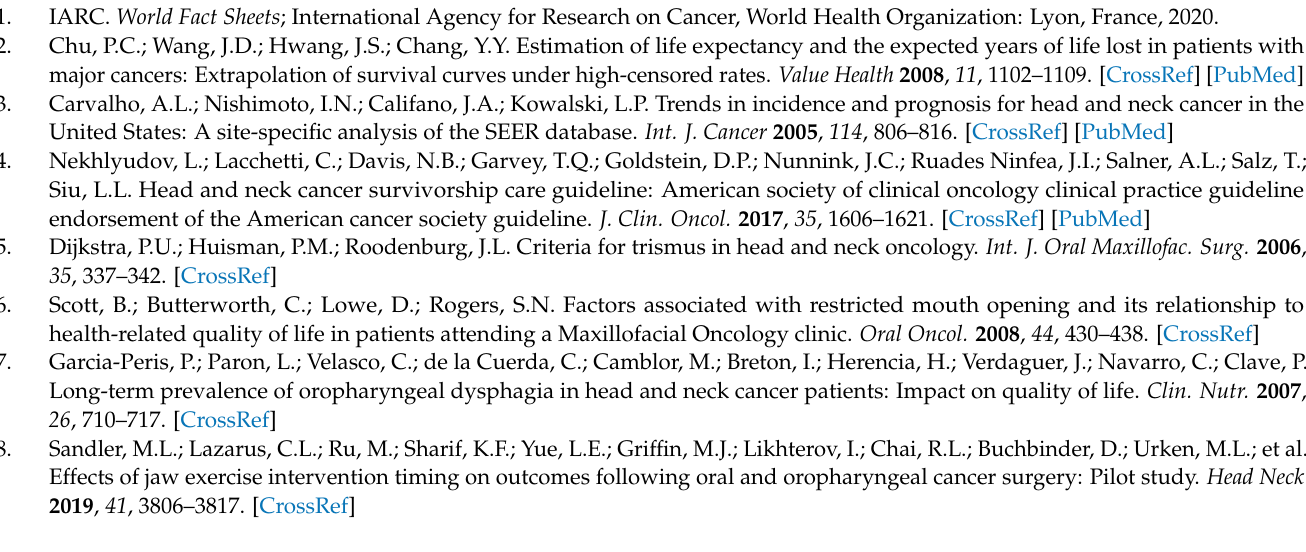
Table S2: Risk of bias assessment, Figure S3: Forest plot of direct evidence on short-term trismus rate, Figure S4: P-Score of short-term trismus rate, Figure S5: Forest plot of direct evidence on longer-term trismus rate, Figure S6: Forest plot of direct evidence on short-term mouth opening level, Figure S7: Forest plot of direct evidence on longer-term mouth opening level, Figure S8: Small-study effect in network meta-analysis of short-term trismus rate, Figure S9: Small-study effect in network meta-analysis of longer-term trismus rate, Figure S10: Small-study effect in network meta-analysis of short-term mouth opening level, Figure S11: Small-study effect in network meta-analysis of longer-term mouth opening level and Figure S12: P-curve of longer-term mouth opening